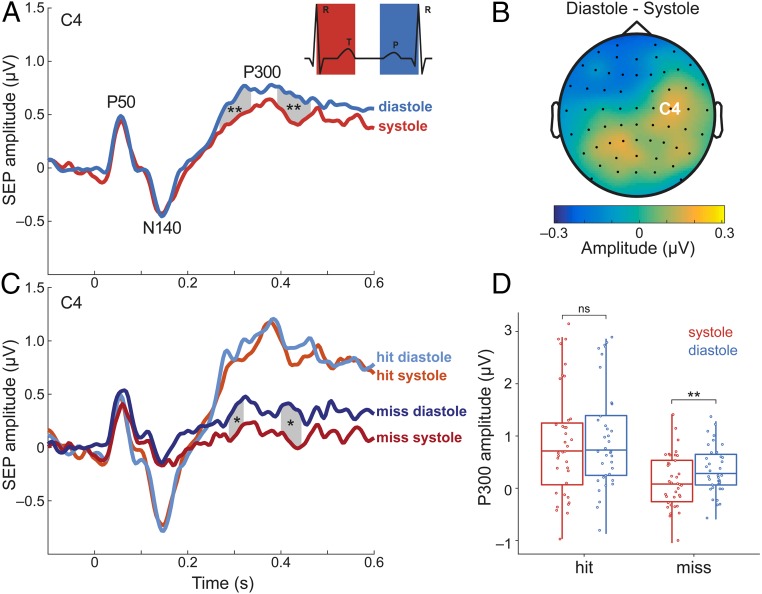
SEPs for stimulations during systole vs. diastole (A) The difference in P300 component of SEPs (electrode C4) between systole and diastole. SEPs were more positive for stimuli during diastole than systole between 268 to 340 ms and 392 to 468 ms after stimulus onset over contralateral somatosensory cortex (Monte Carlo P = 0.004 and P = 0.003, respectively, corrected for multiple comparisons in time). (B) The topography contrast between diastole and systole between 268 and 468 ms. The position of electrode C4 is shown on the head model. (C) SEPs for hits (lighter colors) and misses (darker colors) during systole (red) and diastole (blue). SEPs showed higher positivity for misses during diastole than during systole in two time windows: 288 to 324 ms and 400 to 448 ms (P = 0.02 and P = 0.01, respectively). (D) The mean SEP amplitude between 268 to 468 ms for detection and cardiac phases. *P < 0.05, **P < 0.005; ns, not significant.